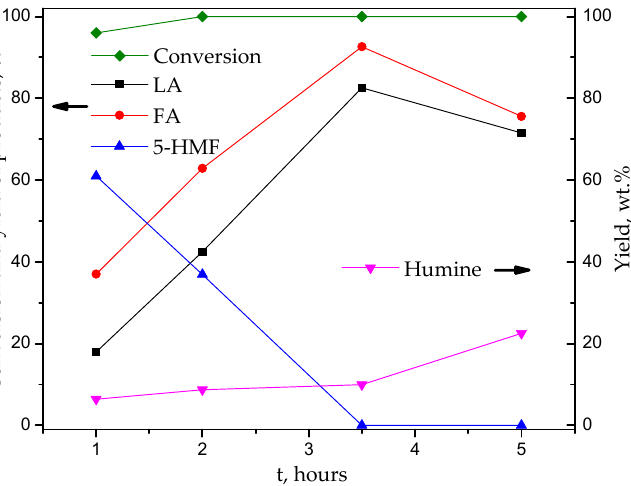
Figure 5. Fructose conversion and yield of products versus reaction time. Reaction conditions: fructose (2 g, 11.1 mmol, 20 wt.%), H 2 O (10 mL), ZrO 2 –SiO 2 –SnO 2 catalyst (0.1 g) at 180 °C.